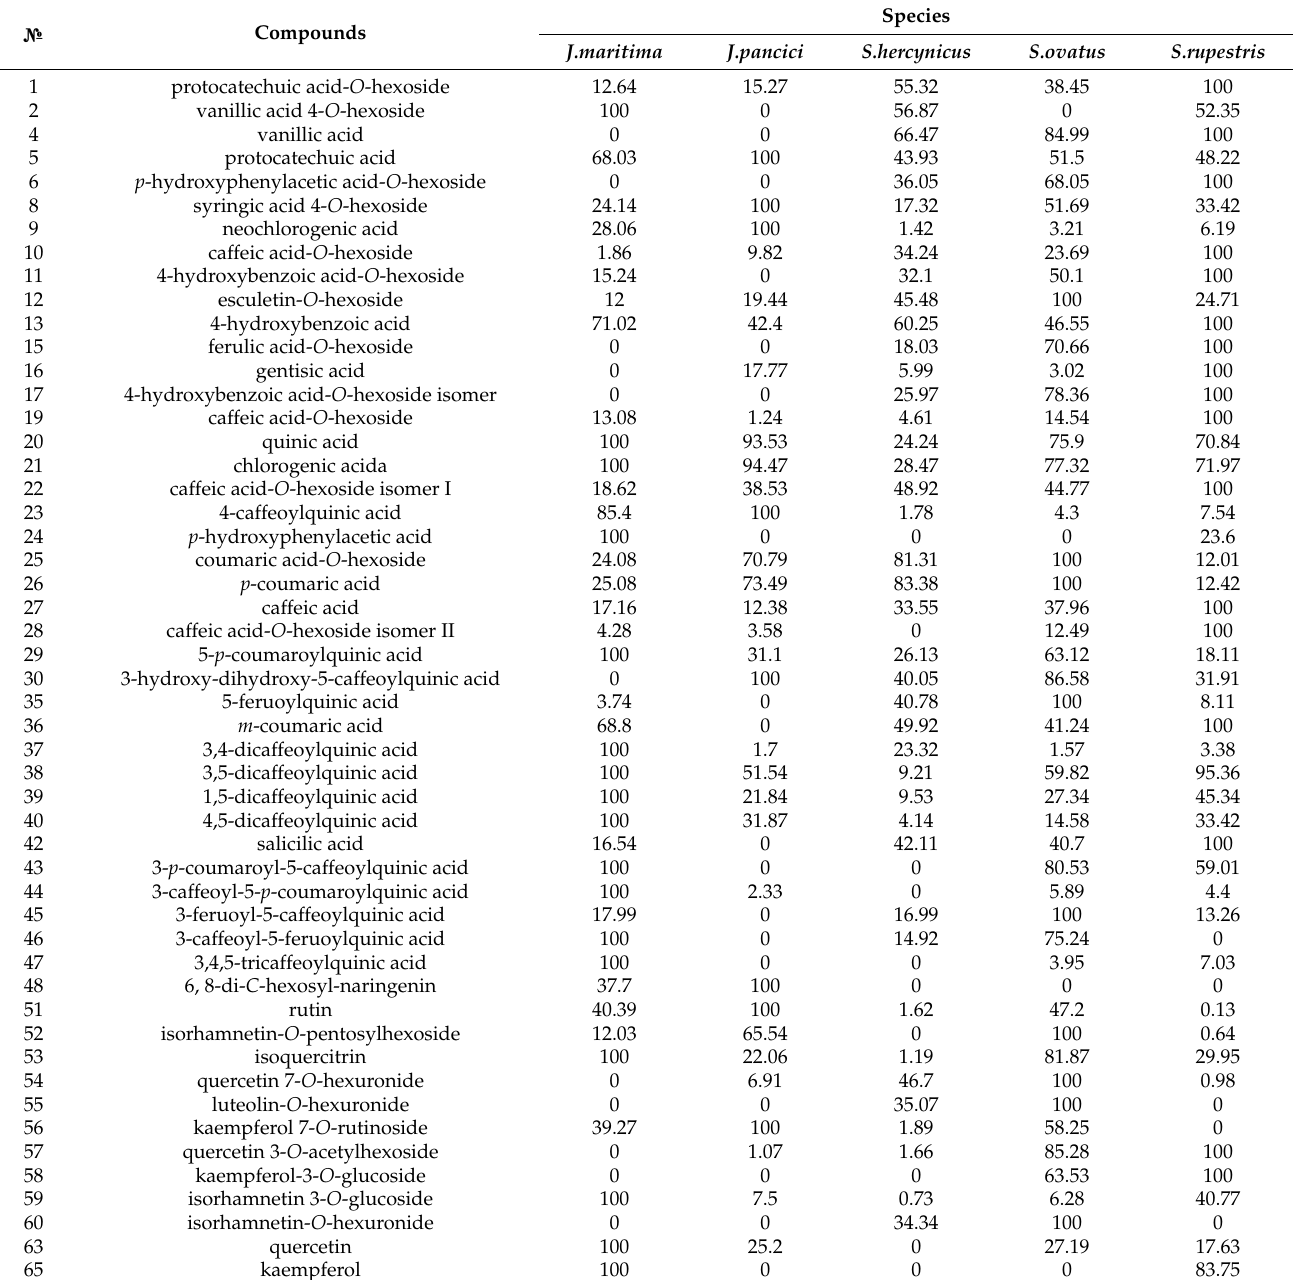
Table 2. Normalized (by rows) AUC values of the identified specialized natural compounds found in at least two, out of all five, studied species. The cells show the normalized AUC, from 0 (in case the compound was not detected in the extract) to 100, by